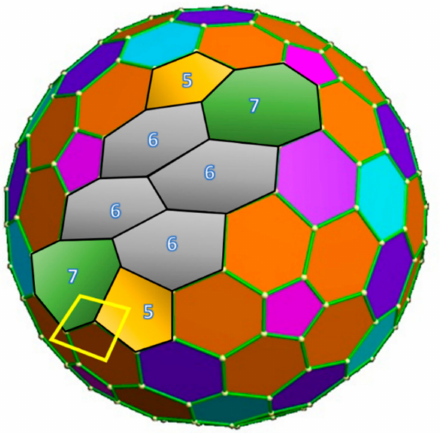
η = 2 Figure 4. The molecule of the C fullerene. It exhibits the extended dislocation dipole generated by 240 applying two SW 6 | 7 rotation to the configuration shown in Figure 3b. The topological defect consists of two pairs of 5 | 7 and two pairs of 6 | 6 in between (the faces are numbered according to the number of carbon atoms in the ring). The molecule is ready for another SW 6 | 7 rearrangement involving the lower pair 5 | 7 and two neighboring hexagons (marked with yellow diamond) to produce the C (not